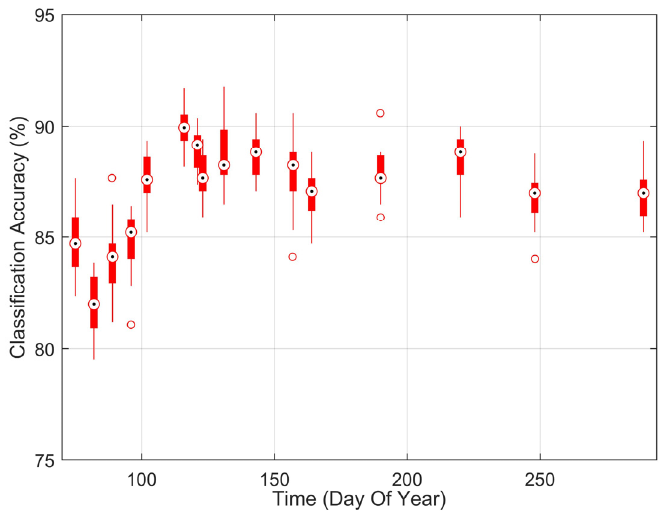
Figure 2. Classification accuracy distribution over time using hyperspectral imaging for identifying infected and non-inoculated control seedlings using a 10-fold cross-validation, repeated 19 times. Note that there was a time dependency on the accuracy of HSI, increasing from 80% at the start of the experiment to 90% mid-season.